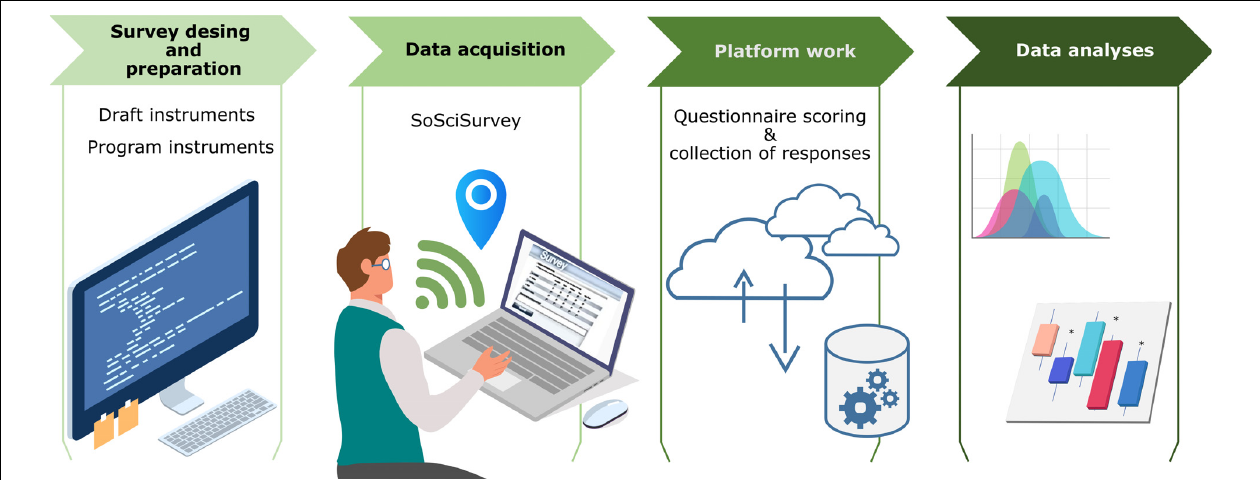
FIGURE 1 | Schematic presentation of the experimental design. From left to right: After designing the online questionnaires (directly from article questionnaires), they were put online and recruitment of participants started. The questionnaires were automatically scored and collected to a local computer for subsequent statistical